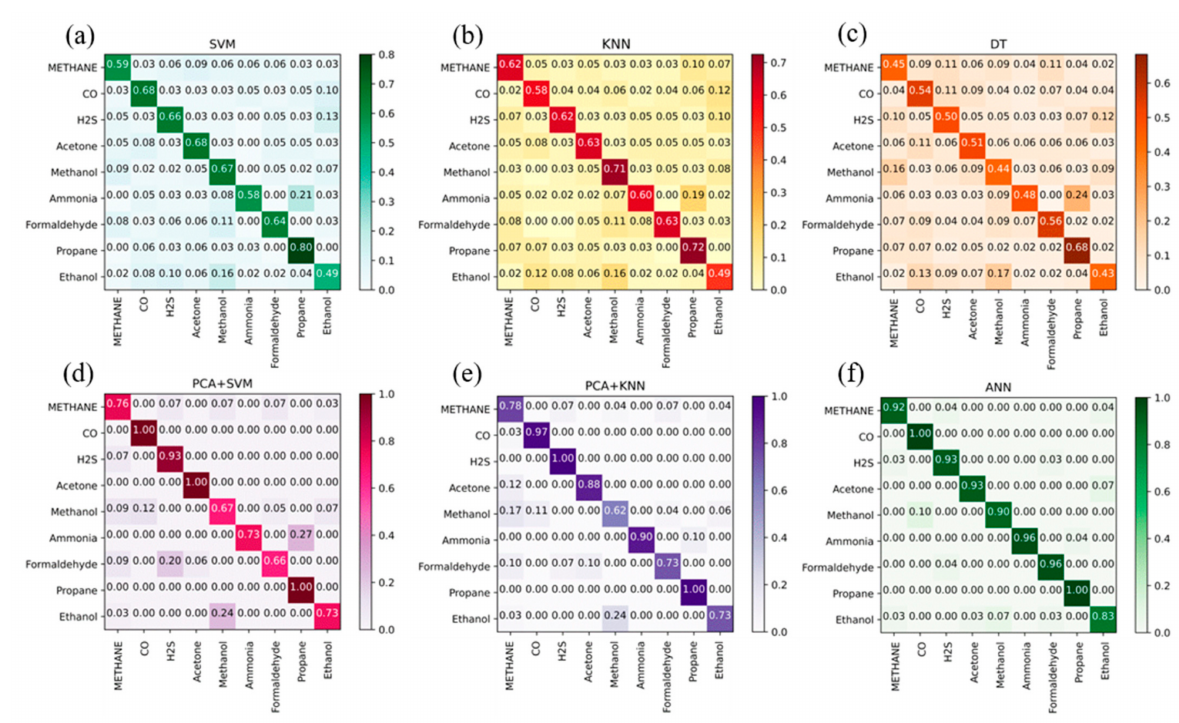
Figure 9. The confusion matrix for the accuracies of ( a ) SVM; ( b ) KNN; ( c ) DT; ( d ) PCA+SVM; ( e ) PCA + KNN; ( f ) ANN.